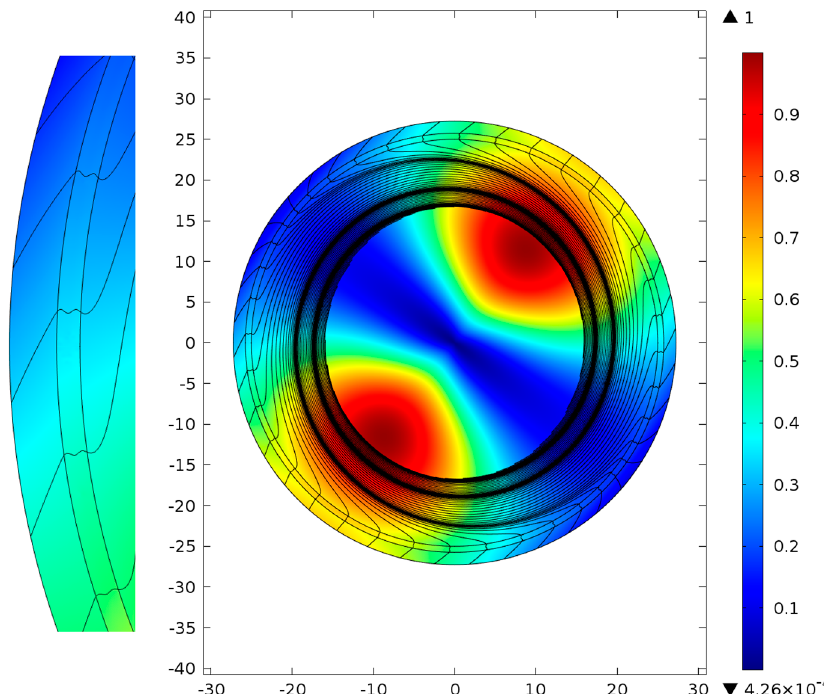
Figure 2. Distribution of the transverse Poynting vector component projection on the radius vector direction in the silica glass capillary cross section. The streamlines for the transverse component of Poynting vector (black lines).